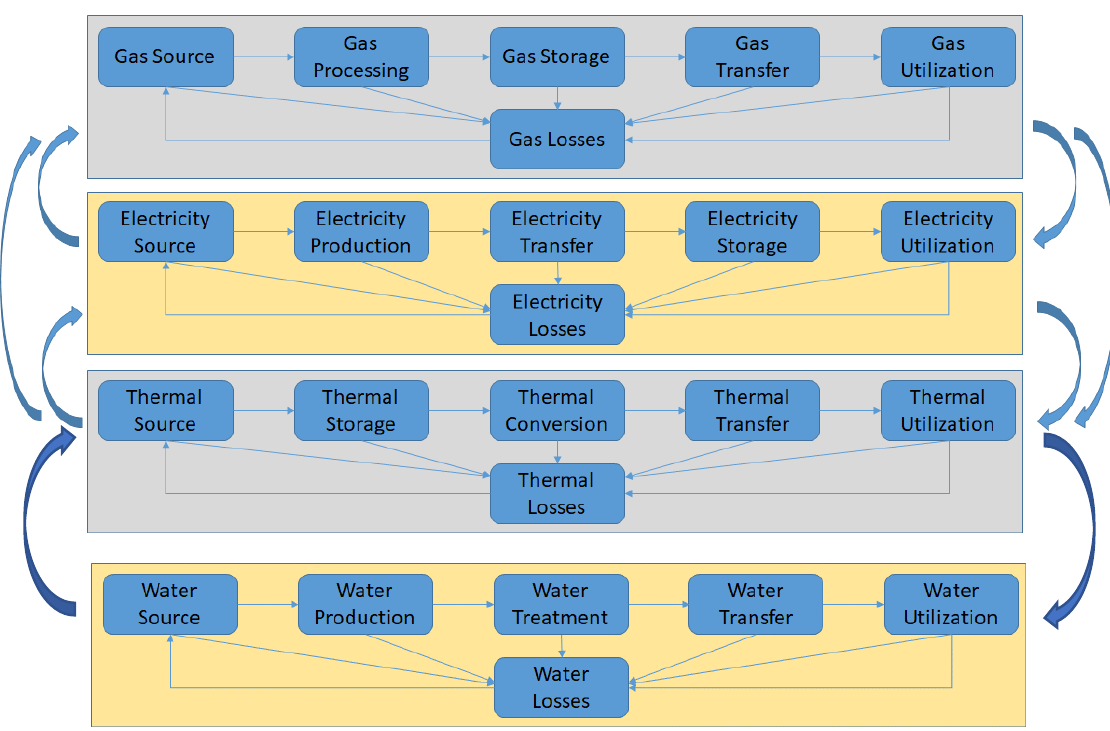
Figure 2. Modeling of energy-water Interconnections.